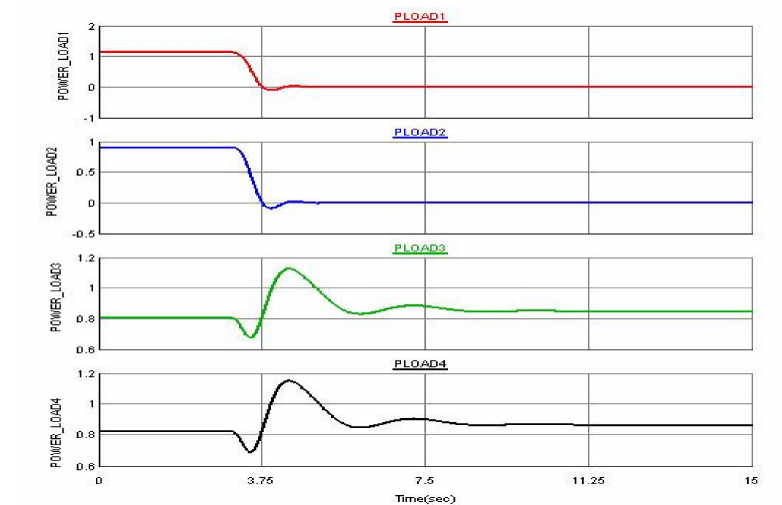
Figure 18. Non-critical loads 1 and 2 are shedded.